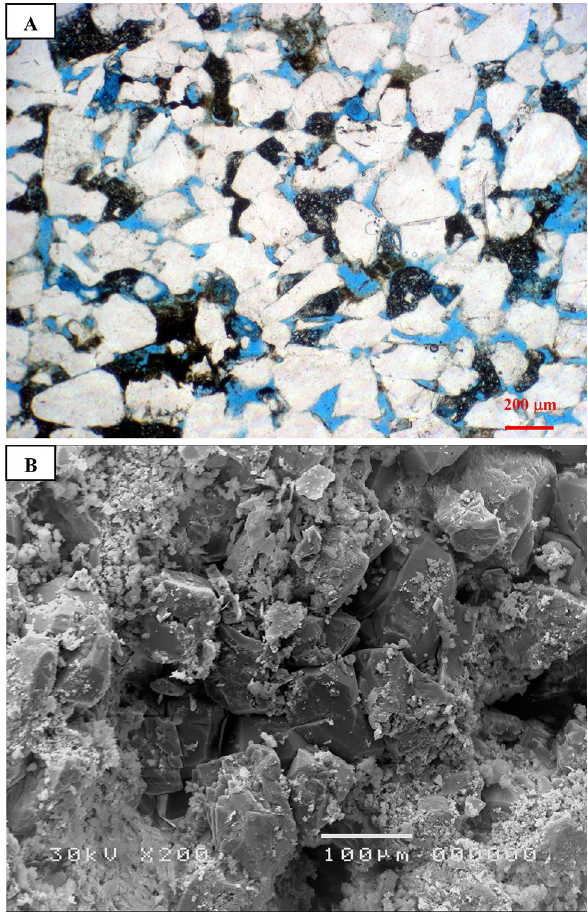
Fig. 2 Photomicrograph of high-porosity quartz arenite, S#3, group (B), ϕ = 29.3%, K = 3578mD. a PPL, b